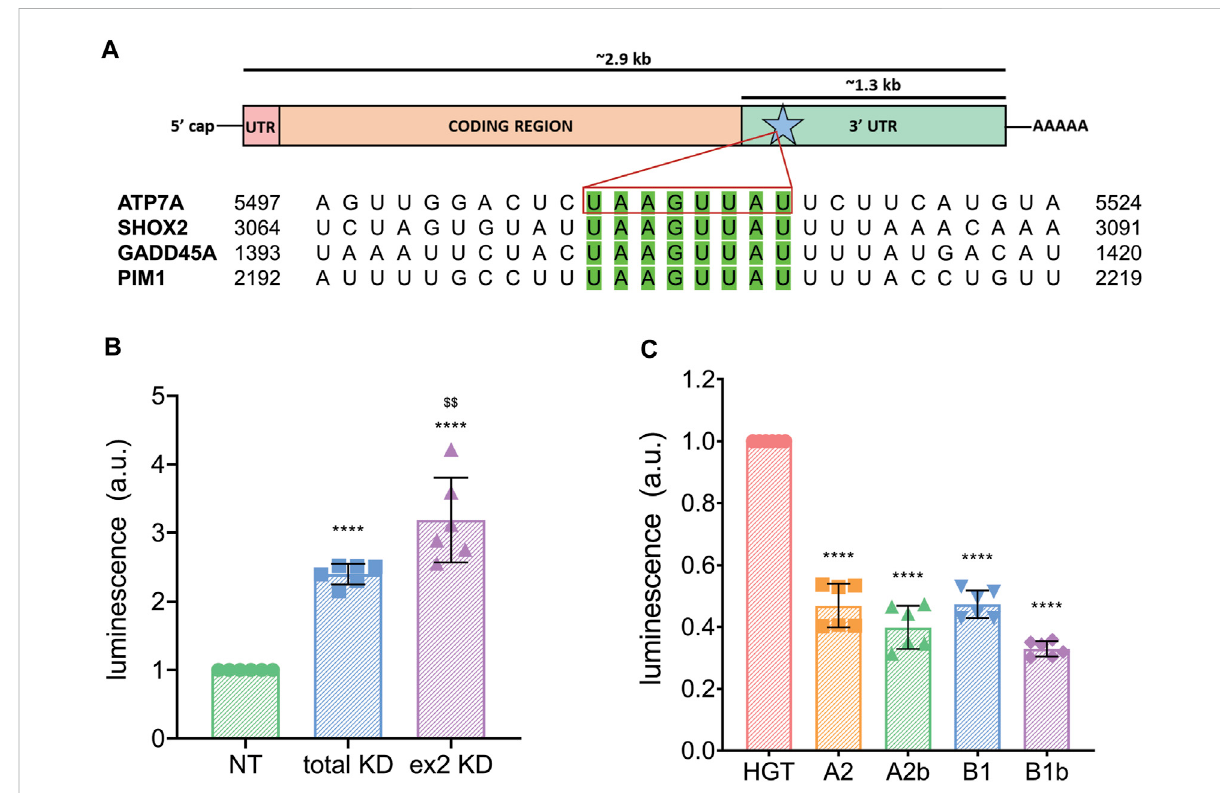
FIGURE 4 hnRNPA2/B1regulates theexpression ofATP7A throughinteractionwith thetransporter ’ s3 ′ UTR. (A) Top,cartoonrepresentationoftheATP7A transcript with the 5 ′ UTR indicated in pink, thecoding region in orange, the 3 ′ UTR ingreen.The 8-ntmotif known to direct hnRNPA2/B1-mediated decay is indicated with a blue star and green color. Box length is indicative of the relative size of these features. Bottom, sequence alignment of known hnRNPA2/B1 targets and ATP7A mRNA within the 8-nt motif. (B) Dual-luciferase assay showing that hnRNPA2/B1 downregulation results in an increase in ATP7A 3 ′ UTR expression. HeLa cells were transfected with non-targeting (NT) siRNA, siRNA against all 4 isoforms of hnRNPA2/B1 (total KD), or siRNA against the exon 2-containing B-isoforms (ex2 KD) for 48 h prior to transfection with ATP7A-3 ′ UTR- fi re fl y luciferase, and Renilla-luciferase for 24 h ( n = 6). (C) HeLa cells were co-transfected with the empty 6x His-GFP-TEV plasmid vehicle (HGT) or individual hnRNPA2/B1 isoformsat the same time as ATP7A-3 ′ UTR-luciferase and Renilla-luciferase plasmids, and dual-luciferase assay was carried out n = 6. All values are reported as means ± SD. Signi fi cance was determined by two-way ANOVA; * p < 0.05, ** p < 0.01, *** p < 0.001, **** p < 0.0001 compared to NT, HGT, or neg, as indicated, and $$ p < 0.01 compared to total